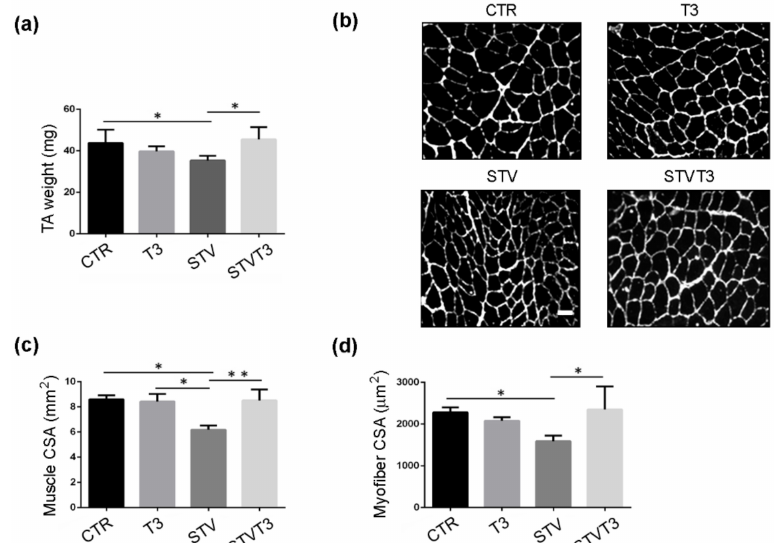
Figure 1. T3 counteracts starvation-induced skeletal muscle loss in Tibialis Anterior. ( a ) TA muscle weight after 48 h of indicated treatments. n = 5 mice per each condition. Data are presented as means ± SD. STV and T3 significantly interact ( p = 0.011) by two-way ANOVA; * p < 0.05 by post hoc Tukey’s HSD test. ( b ) Representative pictures of TA muscles with laminin staining, 48 h after starvation. Scale bar = 20 µ m. ( c ) Morphometric analyses of the whole TA CSA. n = 4 mice per each condition. Data are presented as means ± SD; STV has a significant e ff ect ( p = 0.038); STV and T3 significantly interact ( p = 0.029) by two-way ANOVA; * p < 0.05; ** p < 0.01 by post hoc Tukey’s HSD test. ( d ) Morphometric analyses of myofiber CSA. n = 4 mice per each condition. Data are presented as means ± SD; STV and T3 significantly interact ( p = 0.006) by two-way ANOVA; * p < 0.05 by post hoc Tukey’s HSD